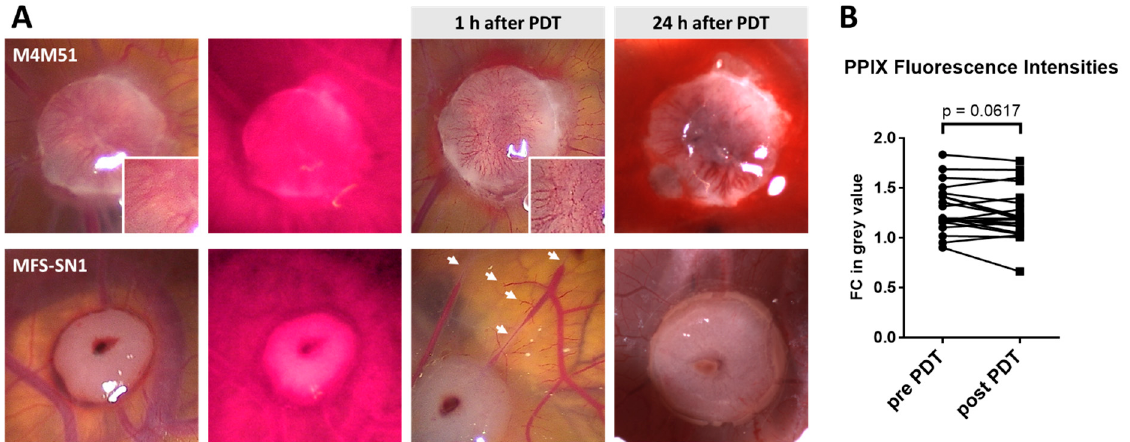
Figure 2. Macroscopic changes upon PDT treatment. ( A ) Examples of blood vessel fragmentation within (upper panel, compare zoom-ins before and after PDT) and surrounding (lower panel, indicated by white arrows) the tumor. Twenty-four hours after PDT, tumors presented as either hemorrhagic (upper panel) or ischemic (lower panel). ( B ) For a subgroup of tumors, PPIX fluorescence intensity was measured before (pre-PDT) and 1 h after PDT (post-PDT). The fold change (FC) in mean grey value of tumor against the background is depicted. Statistical analysis: paired Student’s t -test. M4M51 = Ewing sarcoma; MFS-SN1 = myxo fi brosarcoma.